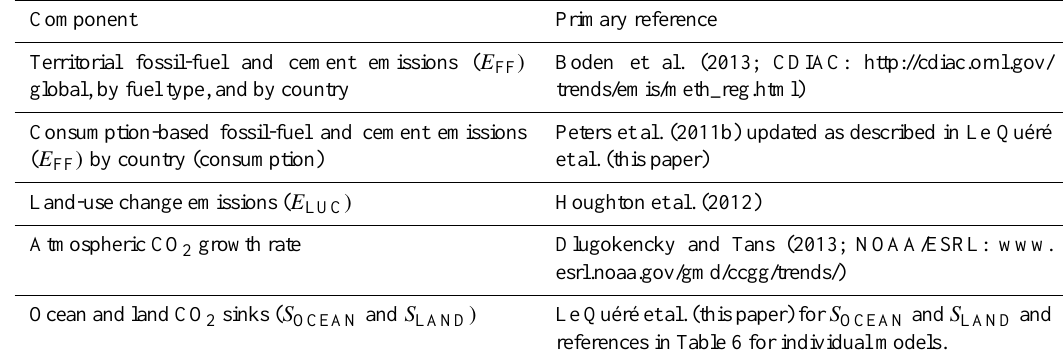
Ocean and land CO 2 sinks ( S OCEAN and S LAND